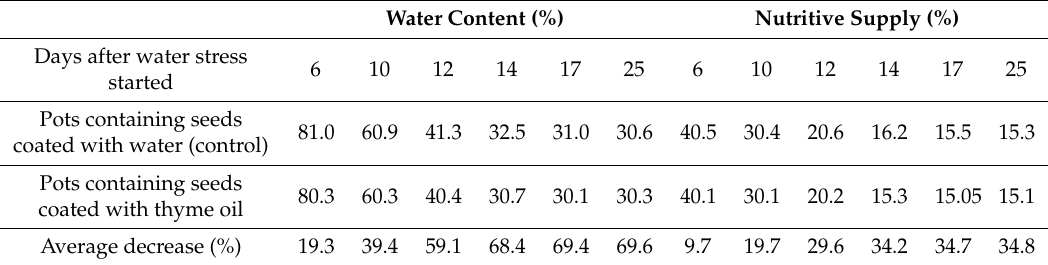
Table 2. Water content and nutritive supply at di ff erent time points of the pots submitted to the water and nutrient stress. Water Content (%) Nutritive Supply (%) Days after water stress started